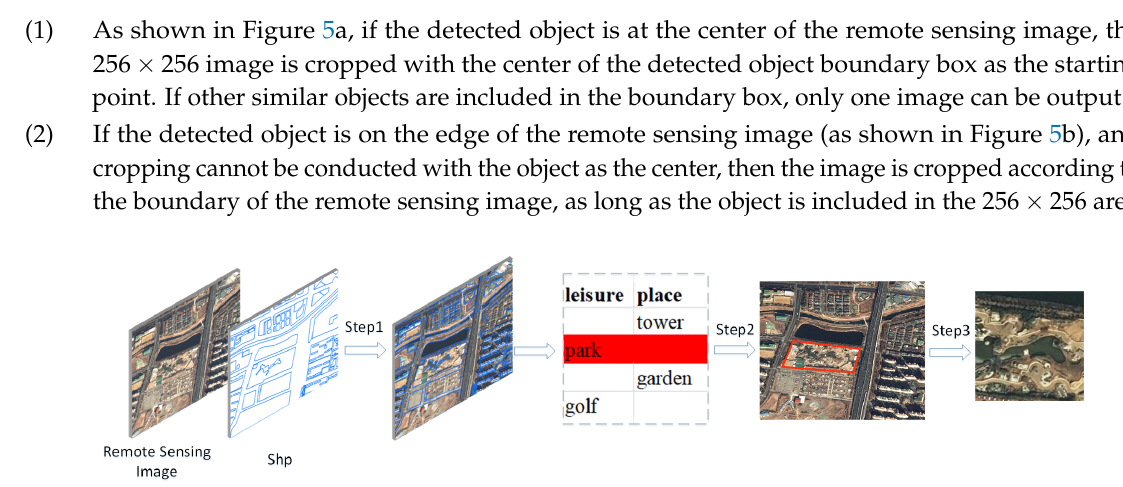
Figure 3. Continual Learning Benchmark for Remote Sensing (CLRS) construction process based